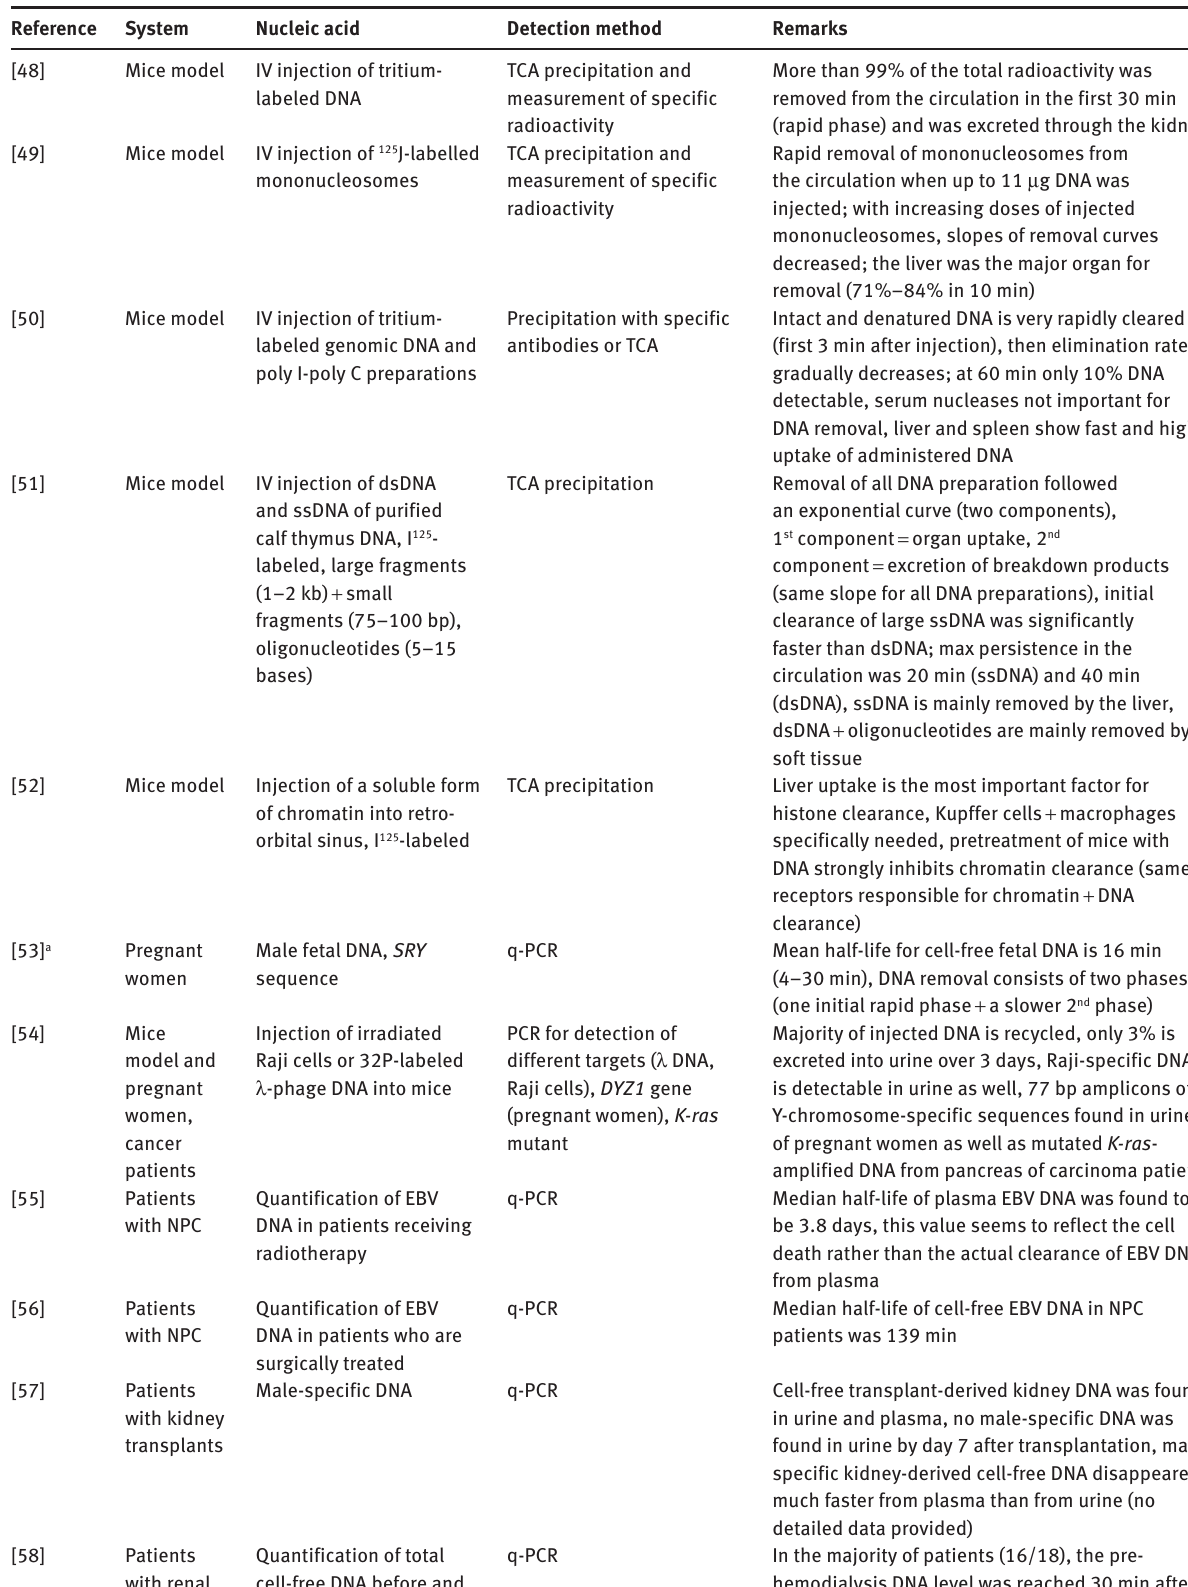
Table 1: Half-life of